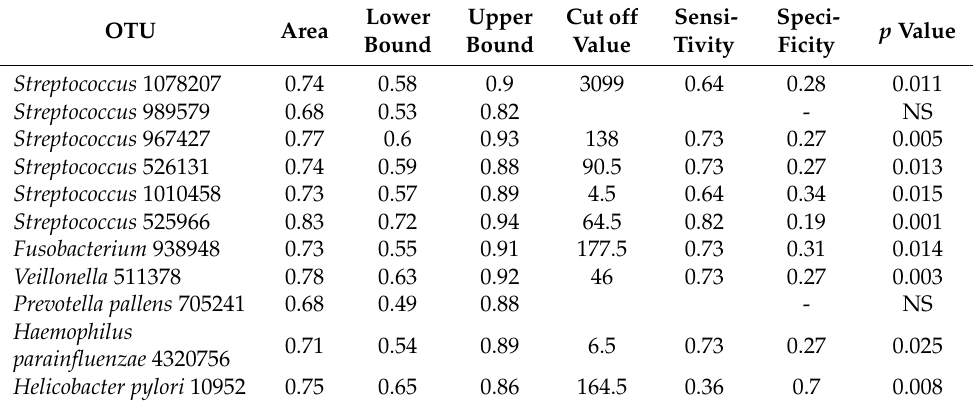
Table 1. The best cut off points for selected microbial candidates of H. pylori -negative gastritis. Lower Upper Cut off Sensi- Speci- p Value OTU Area Bound Bound Value Tivity Ficity Streptococcus 1078207 0.74 0.58 0.9 3099 0.64 0.28 0.011 0.68 0.53 0.82 - NS 0.77 0.6 0.93 138 0.73 0.013 0.73 0.57 0.89 4.5 0.64 0.34 0.015